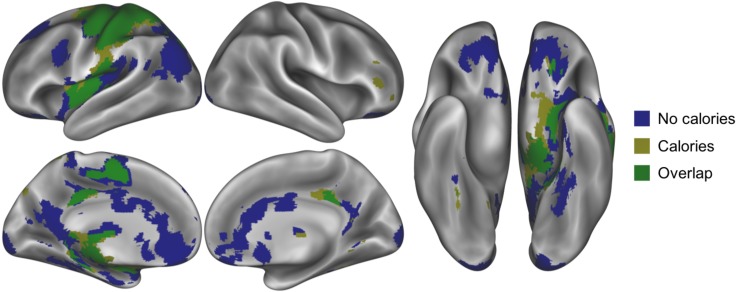
Parametric modulation by food preferences for NO CALORIES and CALORIES.Regions whose activation linearly increased with food preferences when NO CALORIES were present (but not when calories were present) depicted in blue. Regions whose activation linearly increased with food preferences when CALORIES were present (but not when calories were absent) depicted in yellow. Overlapping regions whose activation linearly increased with food preferences for both conditions depicted in green.